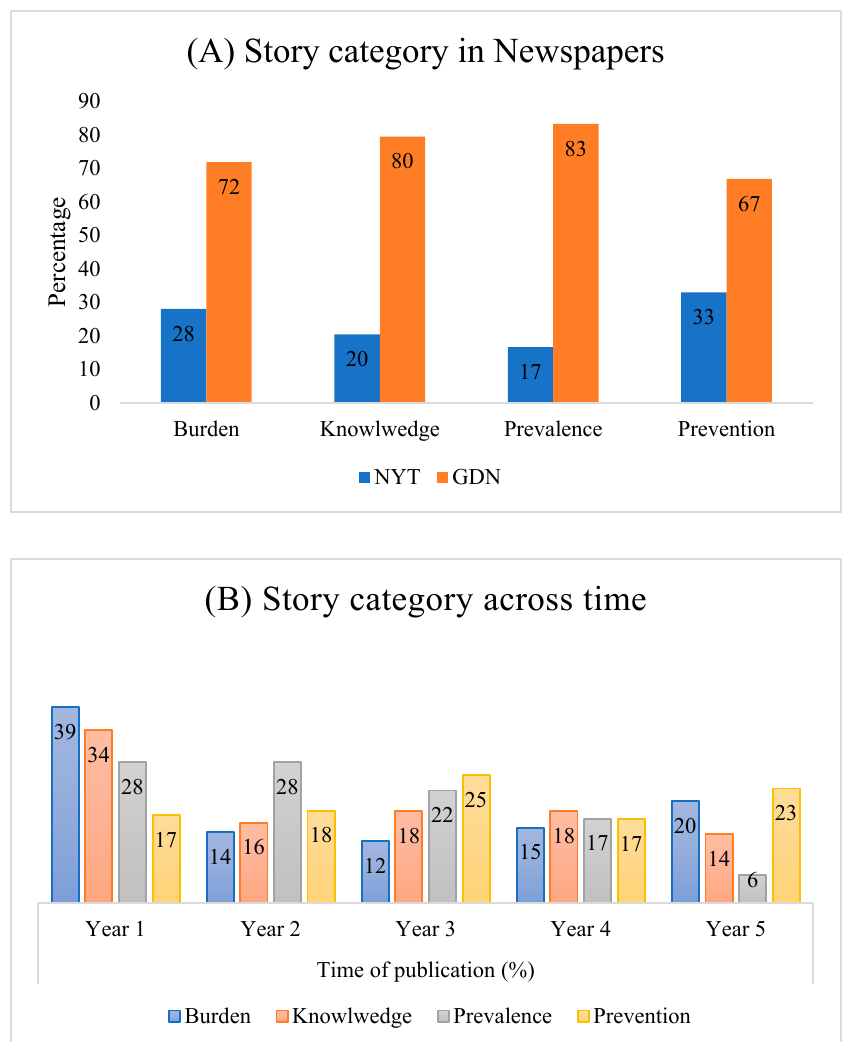
Figure 2. Story category in NYT and GDN from Year 1 to Year 5. ( A ) Story category in NYT and GDN, including burden, knowledge, prevalence, and prevention. ( B ) Story category of different categories across time from both NYT and GDN.